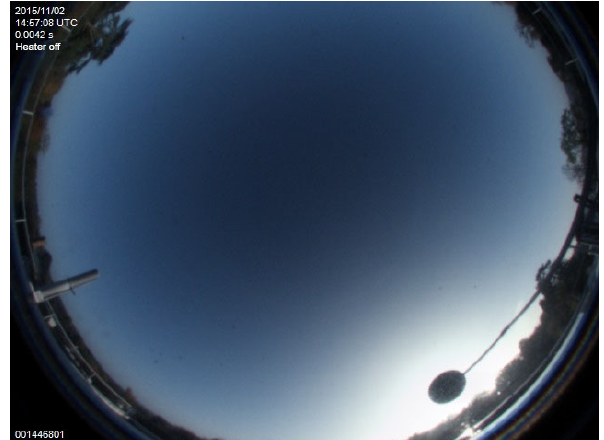
Figure 7. Bayfordbury all-sky daytime sky image used for vi- gnetting correction, 11 February 2015, 14:57.